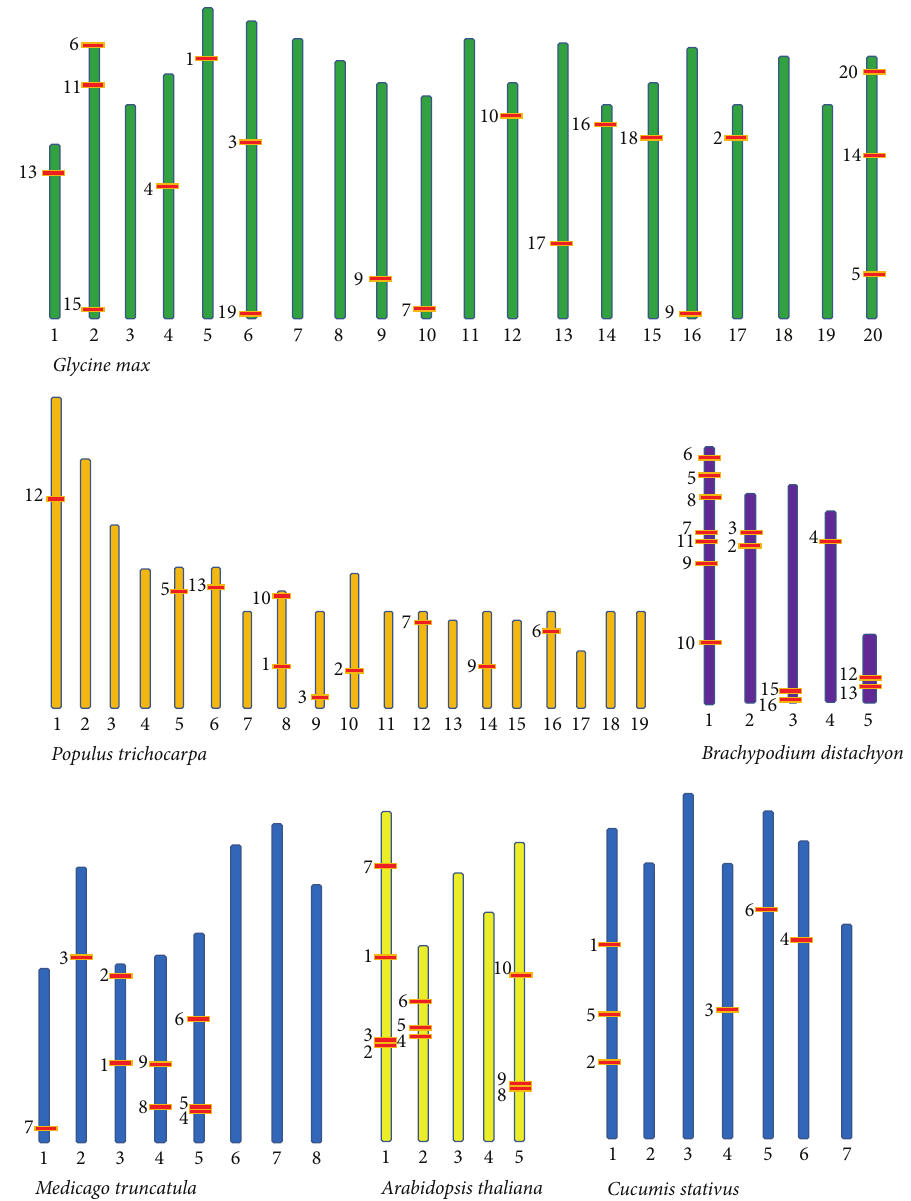
Figure 6: Chromosome distribution and expansion pattern of the Argonaute gene in the A. thaliana, Brachypodium distachyon, Cucumis sativus, Glycine max, Medicago truncatula, and Populus trichocarpa